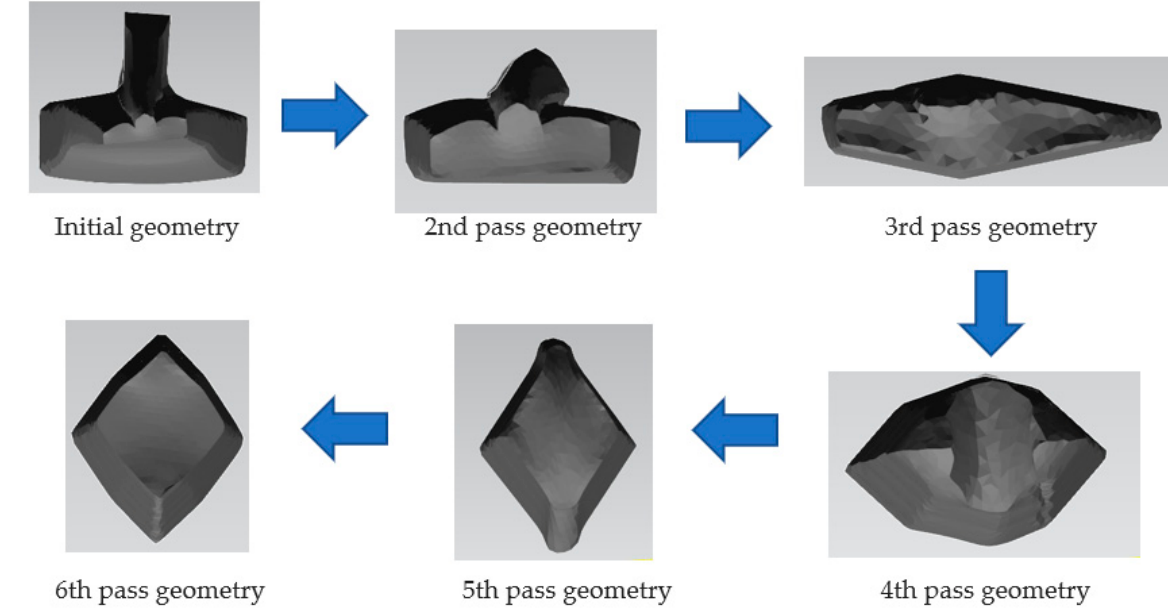
Figure 9. Railway segment for each of five roller passes before and after process.